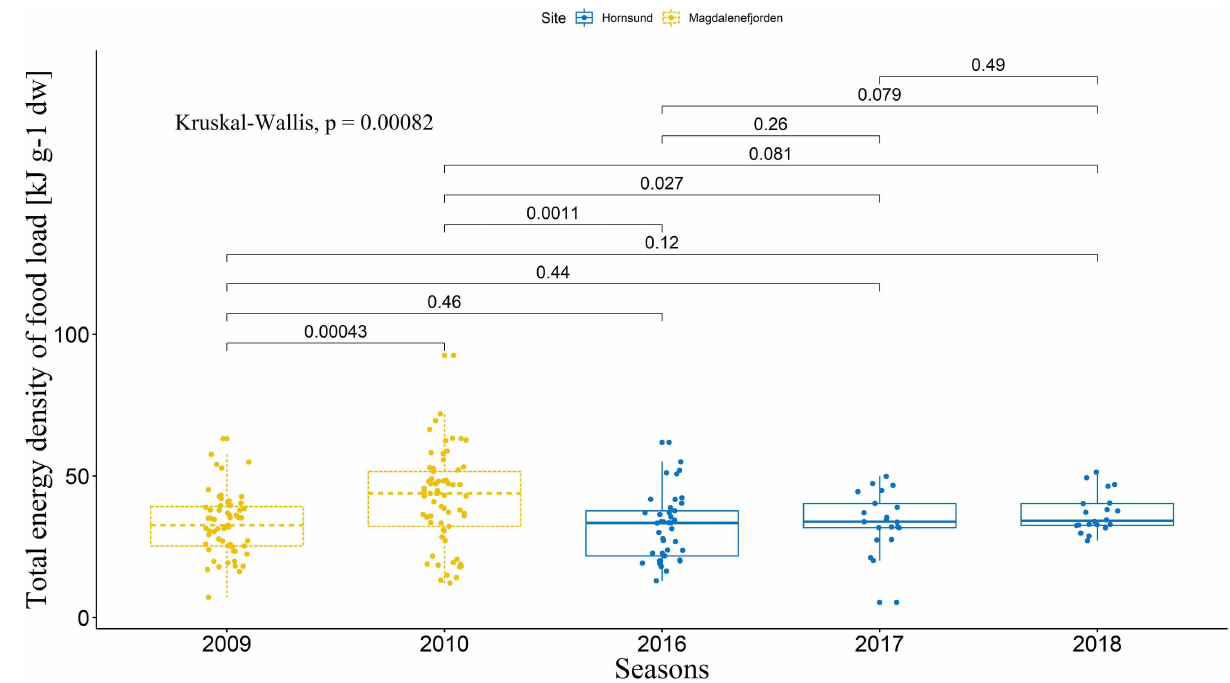
FIGURE 4 | Total energy density of food loads delivered to the chicks during the studied breeding seasons. The boxes depict interquartile range, with median as a bold line inside the box. Whiskers indicate variability outside the upper and lower quartiles. Dots represents the raw data points. Inter-season comparisons were made with a Mann–Whitney U -test, and overall difference was statistically tested with a non-parametric Kruskal–Wallis test. Only Total energy density is presented here as it was highlighted as most important in recursive partitioning analysis (see Figure S1 for other